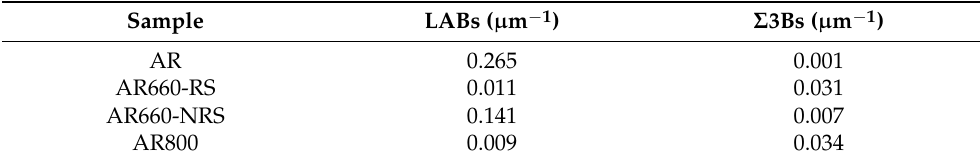
Table 2. Length of LABs (2–10 ◦ ) per area and Length of Σ 3Bs per area.